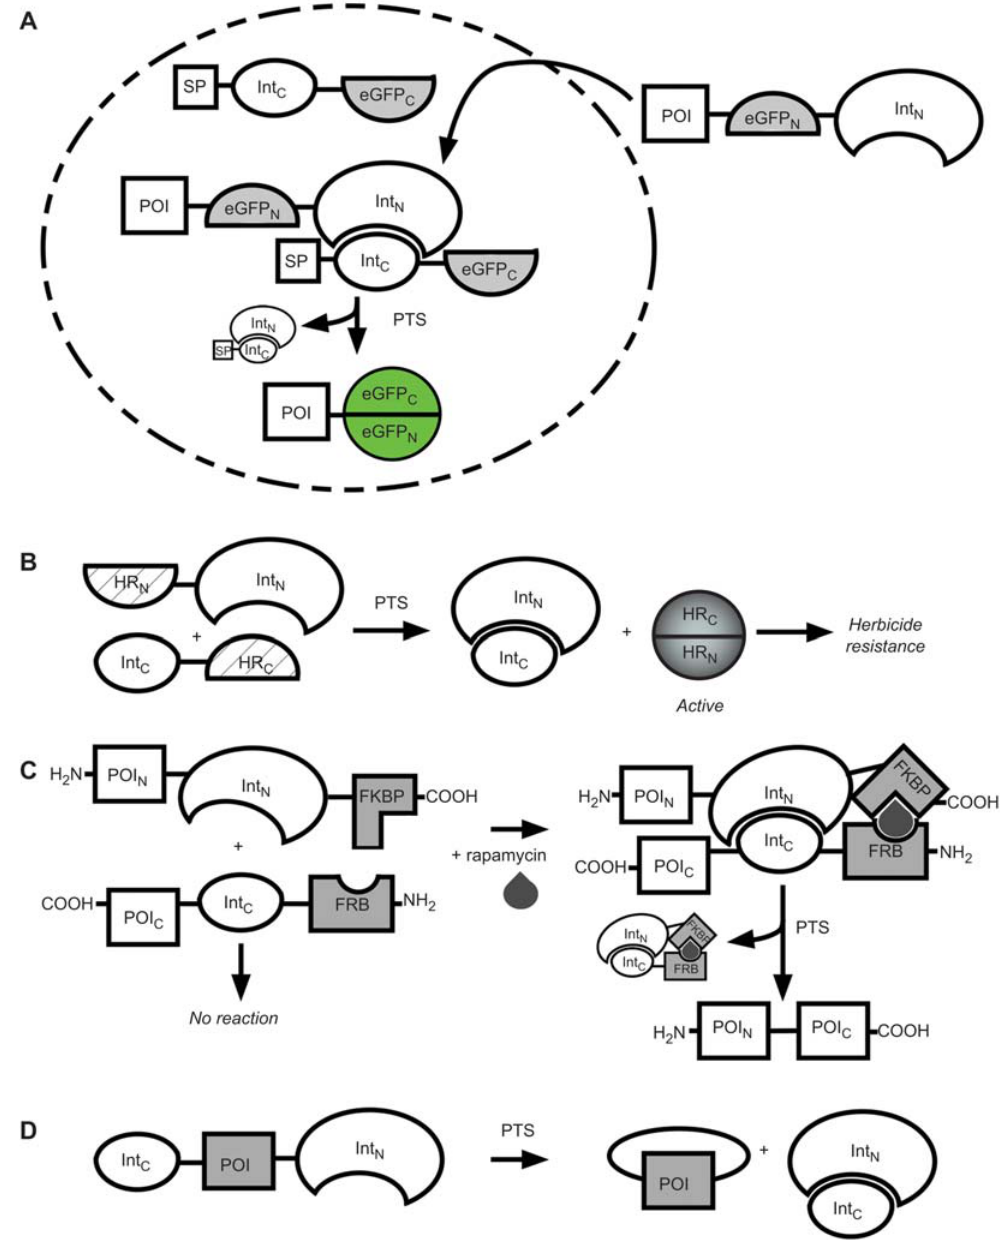
Figure 7 PTS-based protein reconstitution